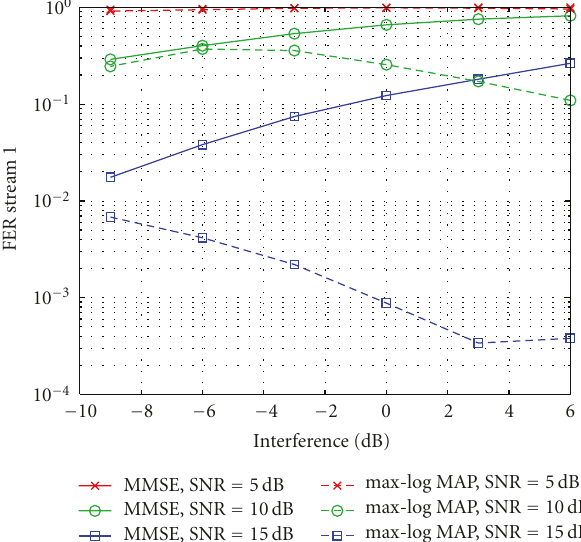
Figure 10: Frame error rate of the first stream of the of the MMSE and max-log MAP receiver for a frequency selective Rayleigh fading channel. Results are plotted for di ff erent SNR levels of the first stream. The x -axis denotes the interference of the second stream w.r.t. the first stream.